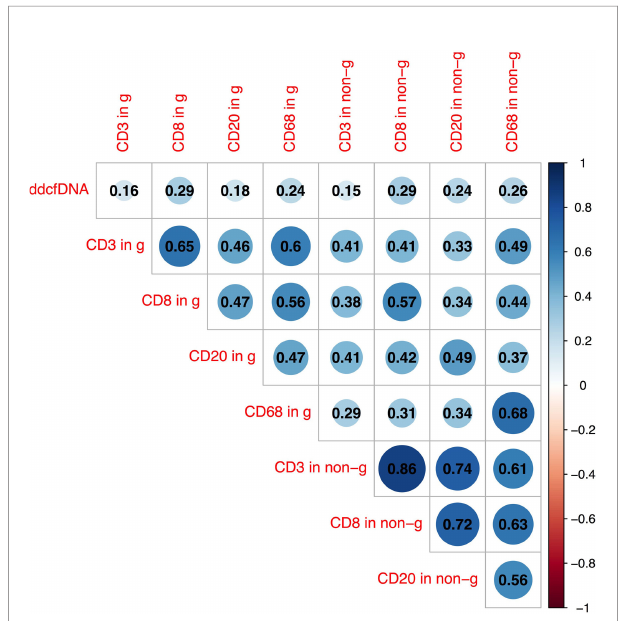
FIGURE 4 | Pearson correlation analysis between plasma ddcfDNA fractions, T cell (CD3+), cytotoxic T cell (CD8+), B cell (CD20+), and macrophage (CD68+) in fi ltration in glomerular as well as non-glomerular area of corresponding biopsies. Numbers in triangle represent correlation coef fi cients (r). Blue bubbles represent positive correlations, while red bubbles represent negative correlations. g, represents glomerular area; non-g, non-glomerular